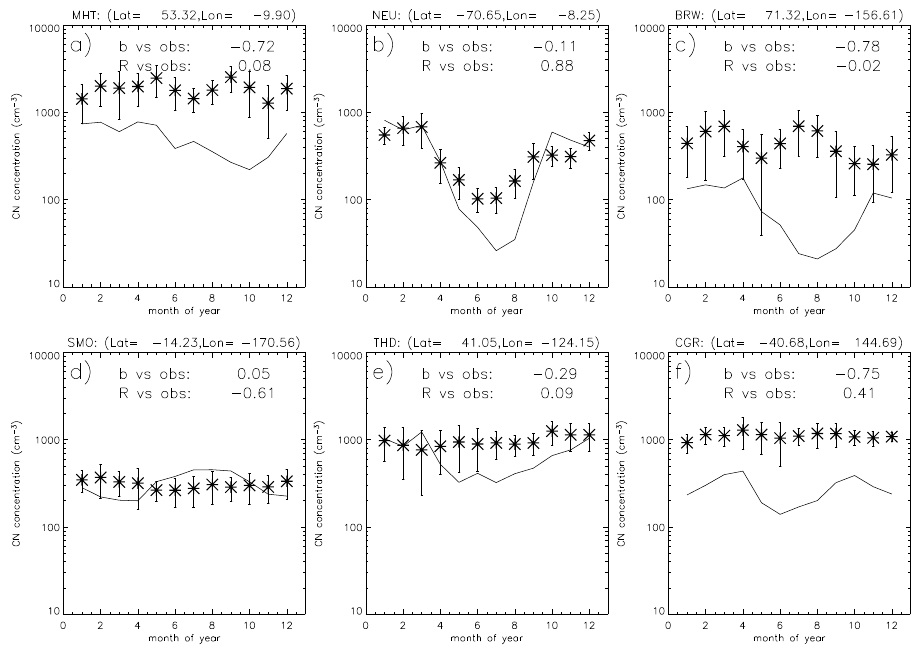
Fig. 19. As Fig. 18 for GAW monitoring stations classified as marine boundary layer sites. Sites are (a) Mace Head, (b) Neumayer, (c) Barrow, (d) Samoa, (e) Trinidad Head, and (f) Cape